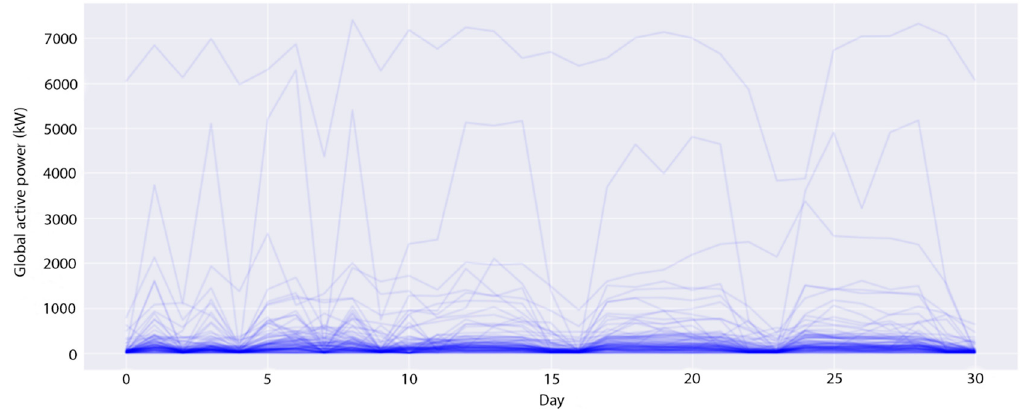
Figure 4. All the daily-load profiles in 30 days of the B1 dataset.